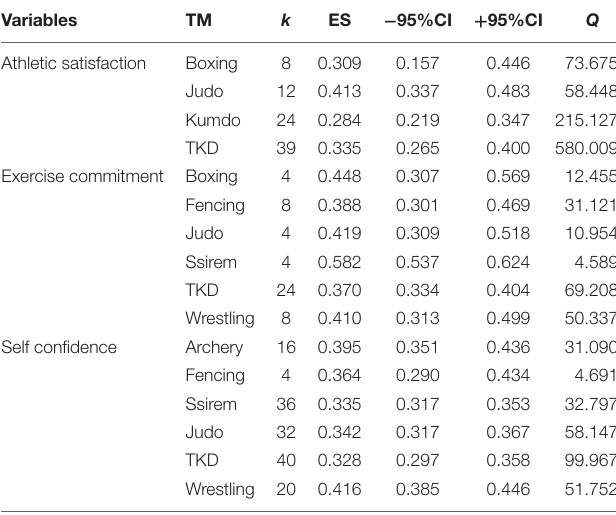
k, Number of comparisons; CI, Confidence interval; TM, Type of martial arts; and TKD, Taekwondo.